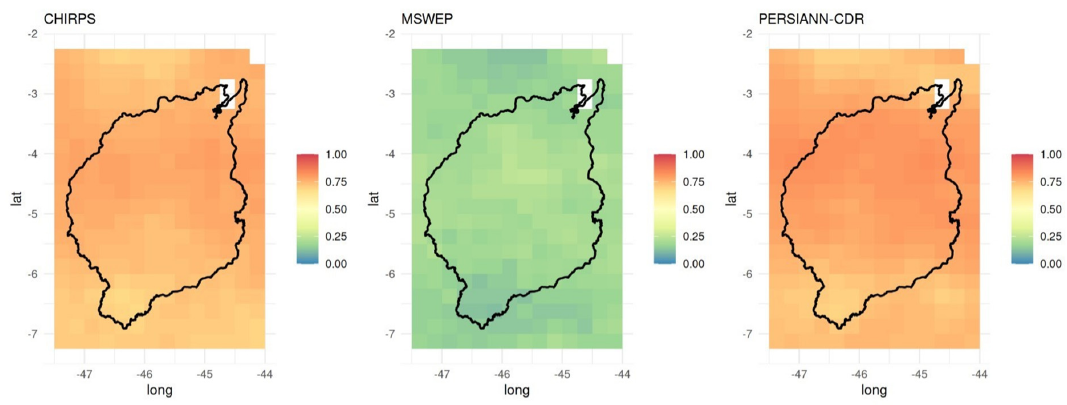
Figure 5. Willmott’s d between gridBR and RES products for the total daily mean from 1983 to 2013. Given the comparison of the monthly mean between the gridBR and the RES prod- ucts for the metrics pbias (Figure 6), RMSE (Figure 7), and Willmott’s d (Figure 8), the